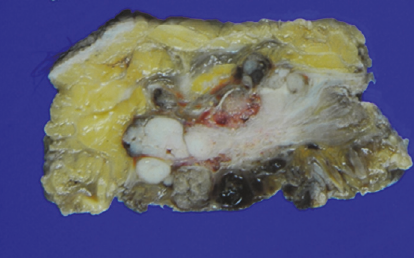
Figure 4: Resected tumor showing the involvement of fat tissue and the abdominal rectus.